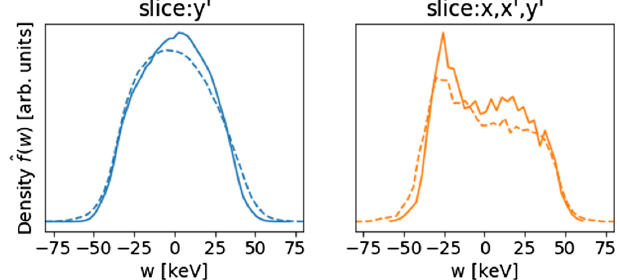
FIG. 16. Comparison of partially projected energy profile for measurement (solid lines) and simulation (dashed lines) for 1D (left plot) and 3D (right plot) slices. Here, ⃗ y 2 ≈ ⃗ y 0 is approxi- mated. The simulated bunch has MEBT current 27 mA. Meas- urement is for 20.5 mA in the